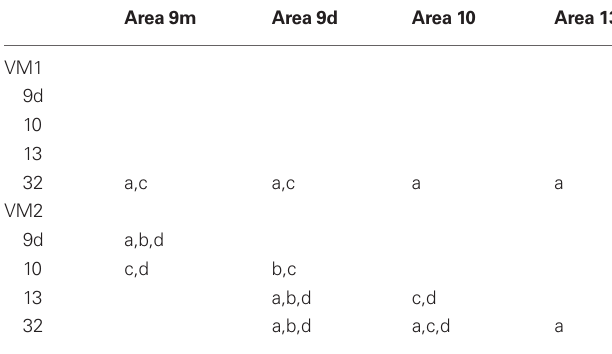
Table 6 | Summary of post hoc pair-wise Scheffe comparisons of morphological parameters of neurons in the vervet